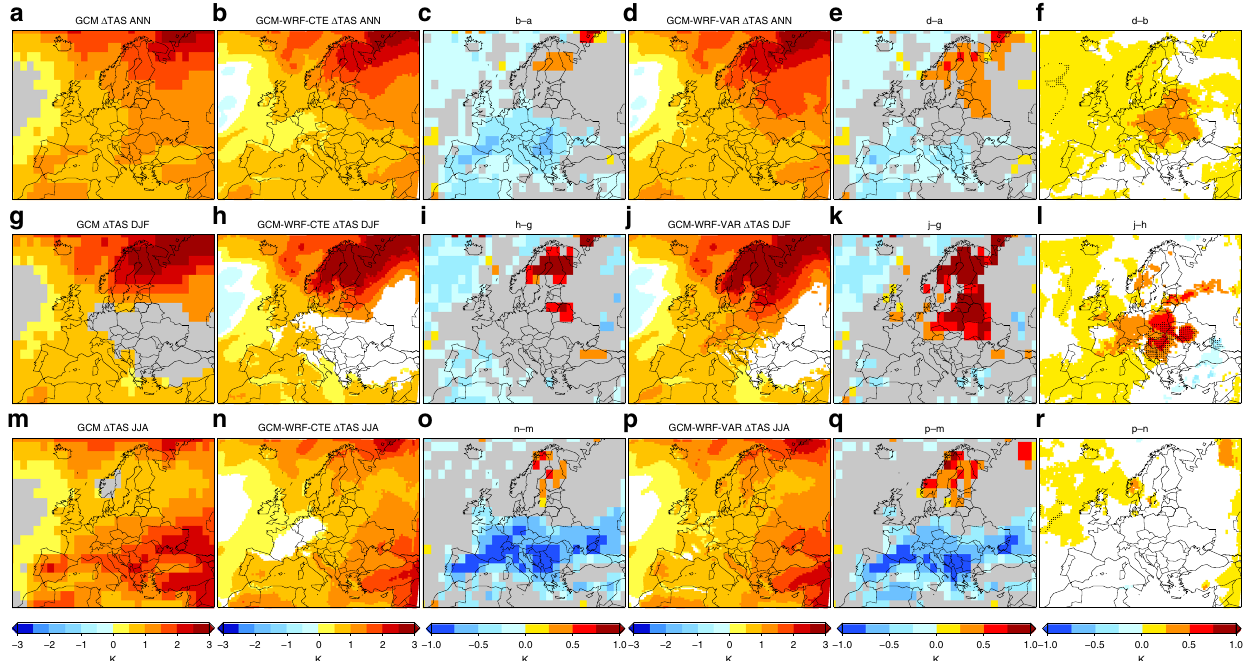
Fig. 2 Near-surface air temperature projections under 1.5°C global warming from global and regional simulations. Projected changes (2011 – 2040 vs. 1971 – 2000 climatologies) in year-mean ( fi rst row), DJF-mean (second row), and JJA-mean (third row) TAS from GCM ( fi rst column, panels a , g , m ) and GCM-driven WRF experiments (CTRL con fi guration, see Table 1), CTE and VAR (second and fourth columns, panels b , h , n , and d , j , p , respectively), along with the differences between ones and others: CTE minus GCM (third column, panels c , i , o ), VAR minus GCM ( fi fth column, panels e , k , q ), and VAR minus CTE (sixth column, panels f , l , r ). The points in the last column indicate that the magnitude of the difference between the VAR and CTE experiments is equal to or greater than the magnitude of the signal from the respective CTE experiment. Only signi fi cant values ( p <0.1) are shown. Units: